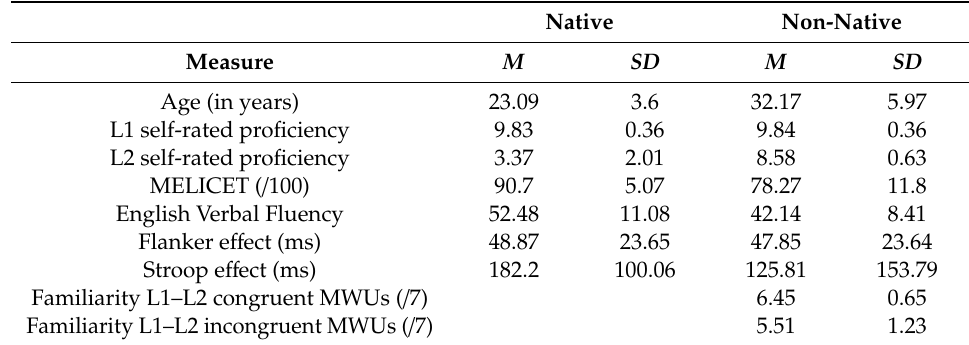
Table 3. Summary of cognitive and proficiency measures. Native